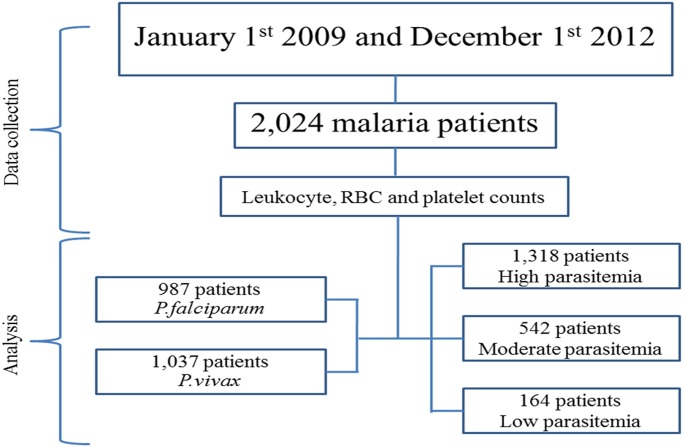
A consort flow diagram showing the flow of cases through the study.